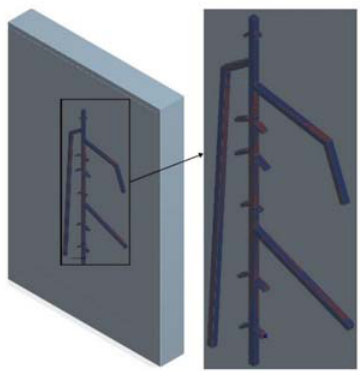
Figure 2. Meshed RSA model showing Node Merge contact